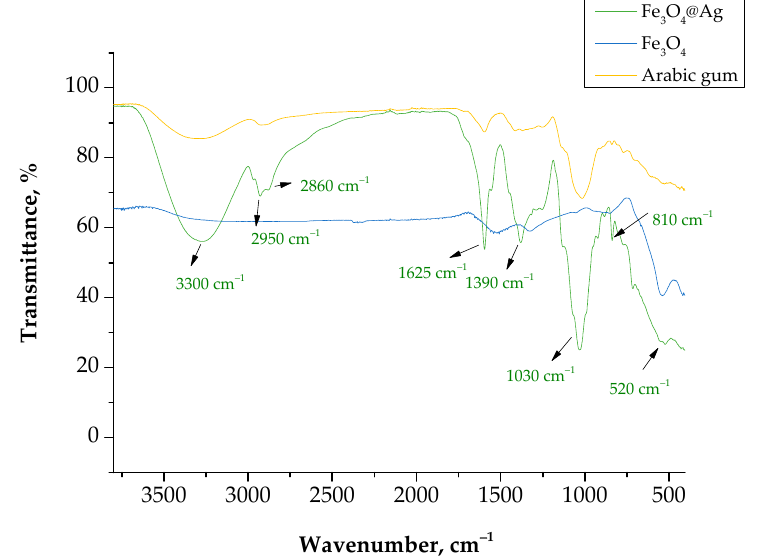
Figure 11. FT-IR spectrum of the Fe 3 O 4 @Ag nanoparticles (green line), Fe 3 O 4 nanoparticles (blue line), and Arabic gum (orange line).